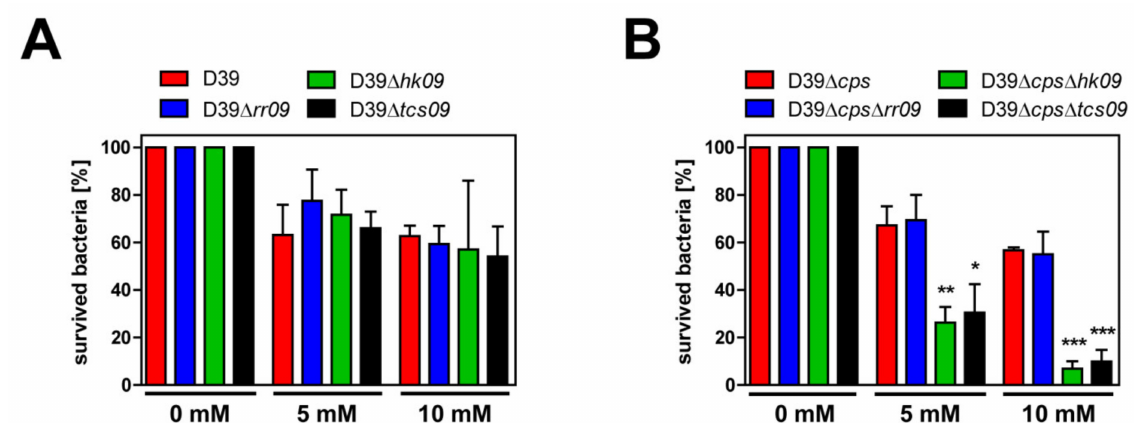
Figure 8. Resistance of pneumococcal tcs09 -mutants against oxidative stress. Survivability of the S. pneumoniae strain D39, D39 ∆ cps , and its isogenic rr09 -, hk09 -, and tcs09 -mutants under oxidative stress conditions. Pneumococci were cultured in CDM up to an OD 600nm of 0.6, and incubation with different H 2 O 2 concentrations was performed for 30 min at 37 ◦ C. The number of CFU were determined by plating a dilution series on blood agar. ( A ) Survival rate of encapsulated D39 and tcs09 - mutant strains. ( B ) Percentage of survived bacteria of nonencapsulated D39 ∆ cps and tcs09 -mutant strains. The measured values, presented as normalized percentage, are shown as mean ± SD of three independently performed experiments. An independent student’s t -test proved a significance with a p -value * < 0.05, ** < 0.01, and *** < 0.001 relative to the parental pneumococcal strain D39 ∆ cps